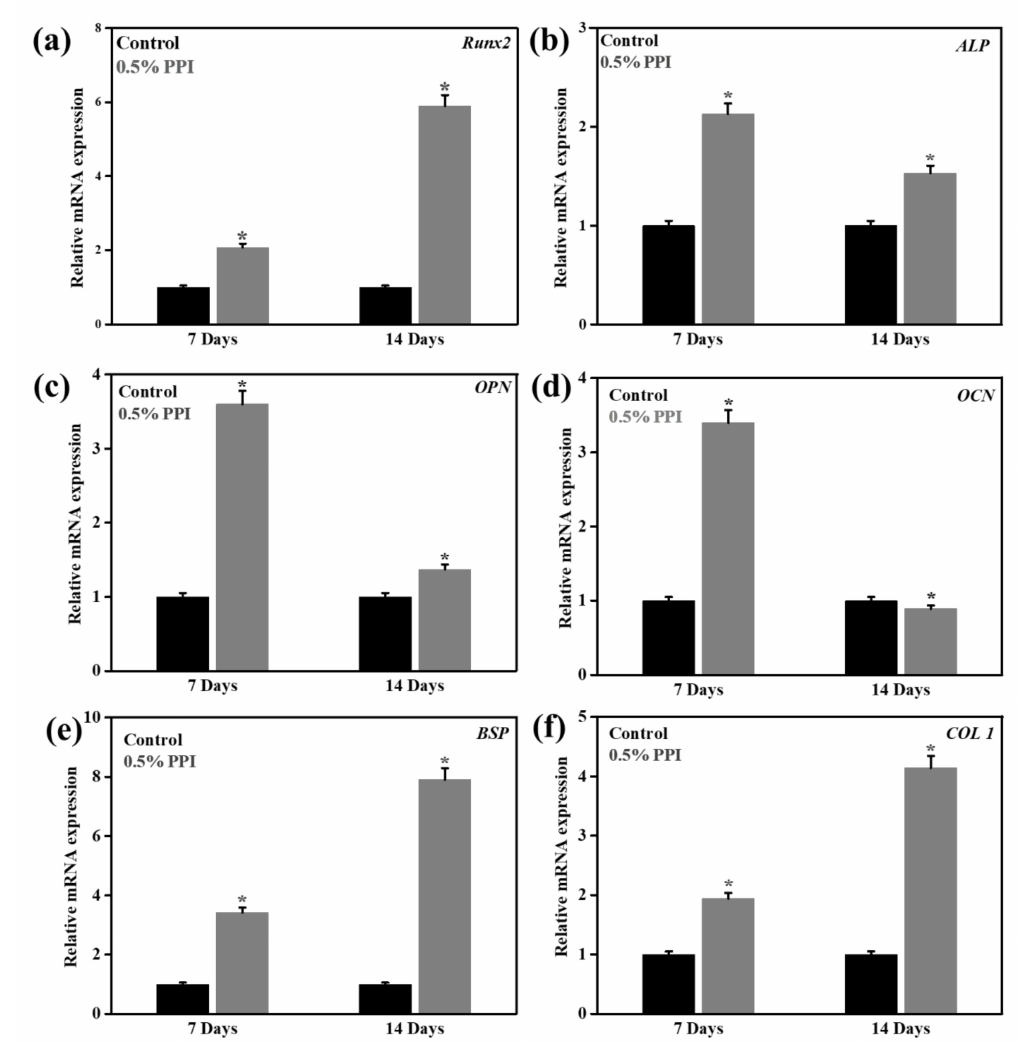
Figure 9. Real-time polymerase chain reaction (qRT-PCR) analysis of PPI-treated hBMSCs after indicated time intervals for, ( a ) Runx2 , ( b ) ALP , ( c ) OPN , ( d ) OCN , ( e ) BSP , and ( f ) COL1 . Data are the mean ± SD of triplicated experiments; statistical significance at * p <